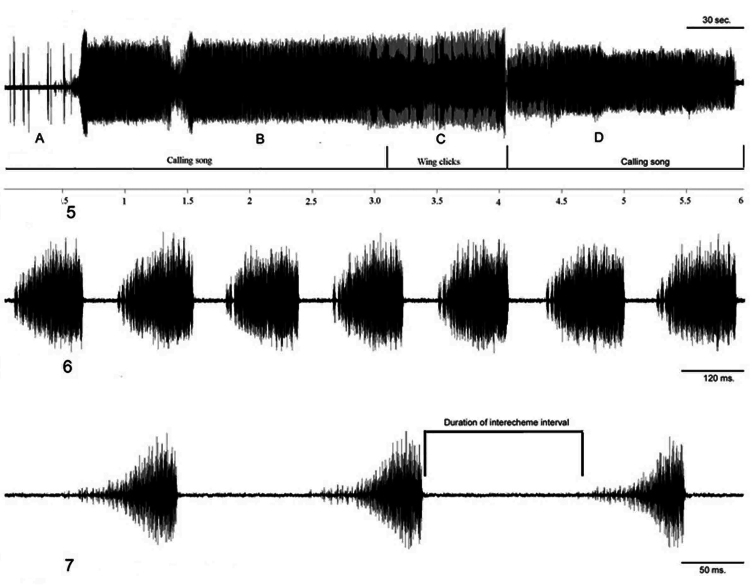
5
Cicadatra platyptera, example of a male song, a whole song A Beginning of calling song B Calling song C Courtship song D Calling song (scale= 30 second) 6
Cicadatra platyptera, male song, 7 echemes from calling song (scale=120 ms) 7 Cicadatra platyptera, male song, 3 echemes from calling song (scale=50 ms).